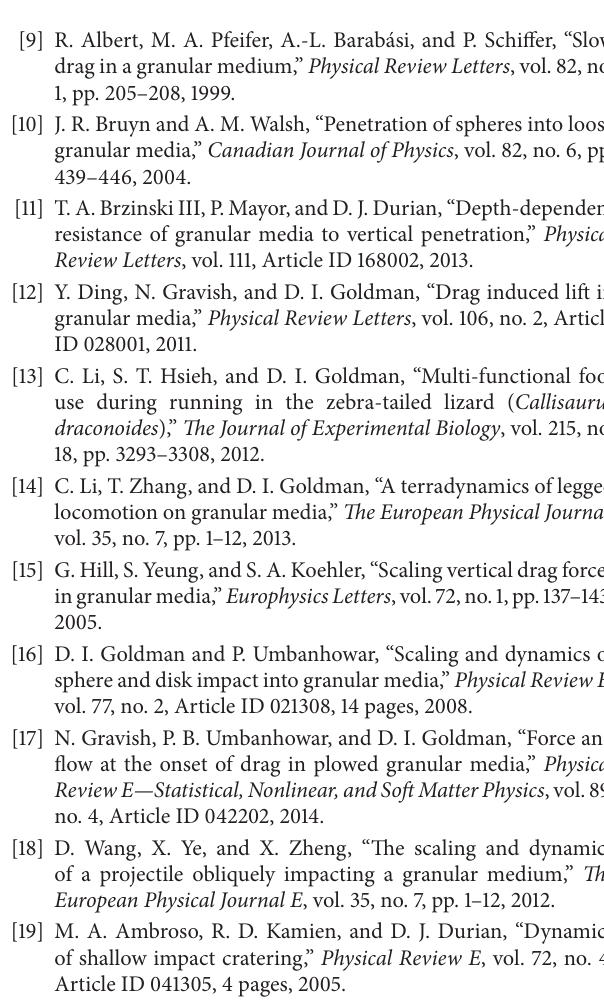
Figure 8: The contribution of the kinetic and potential energy to the total energy dissipation during the penetration phase by the system to the environment: (a) for Link 1 and (b) for Link